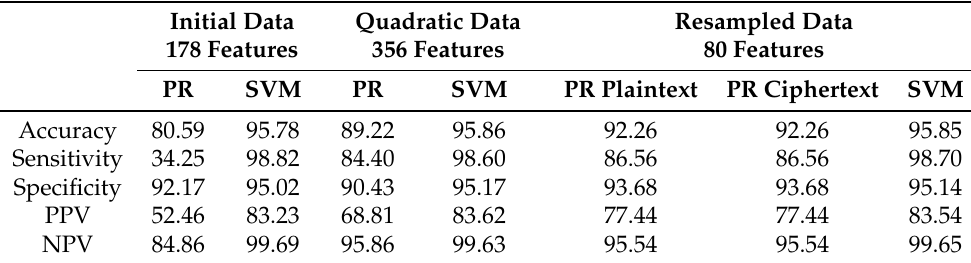
Table 1. Performance comparison when using different input data configurations in the EEG-based seizure detection use